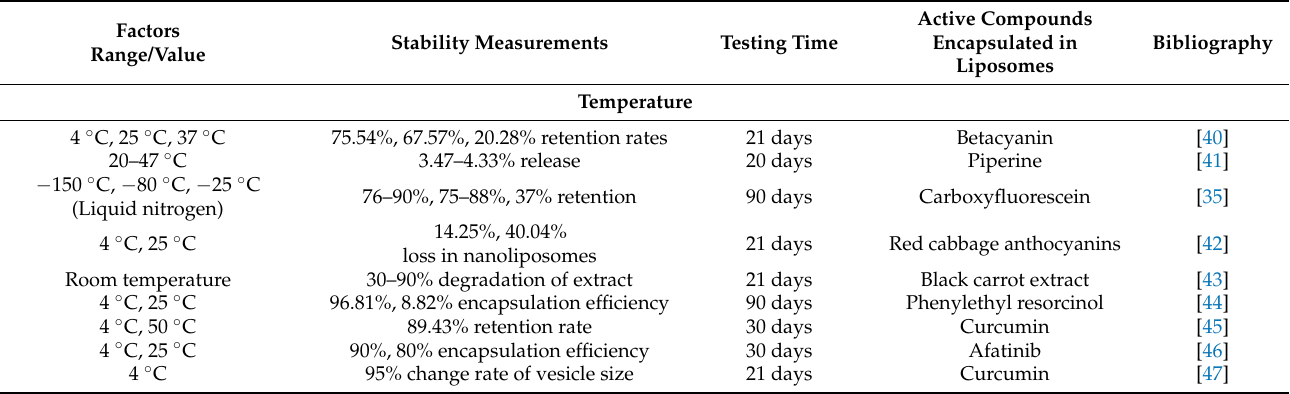
Table 1. Influence of physical factors on liposome